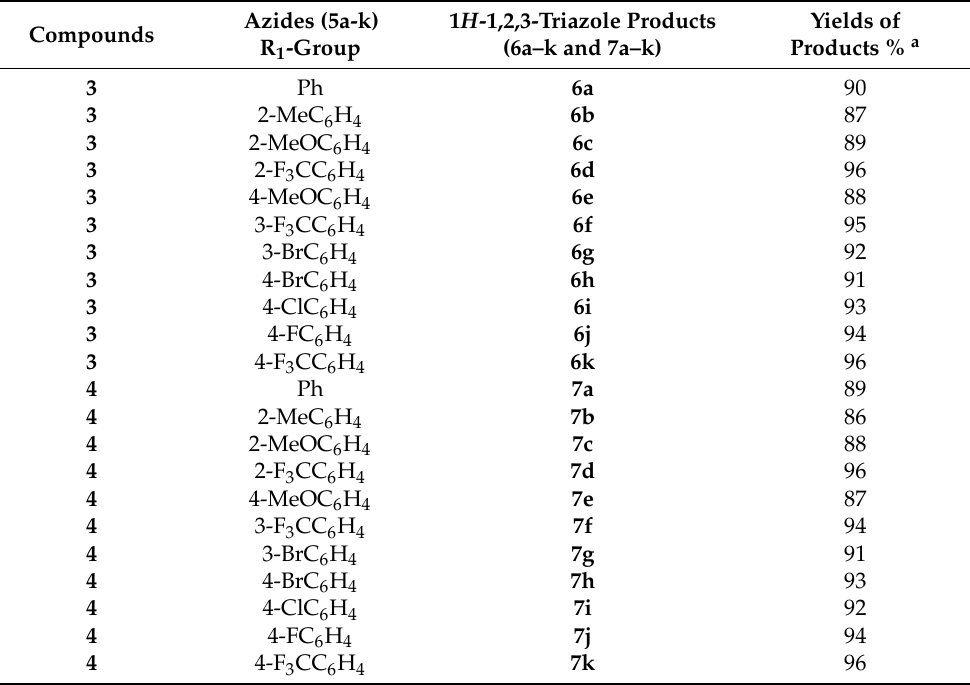
Yields of Products %